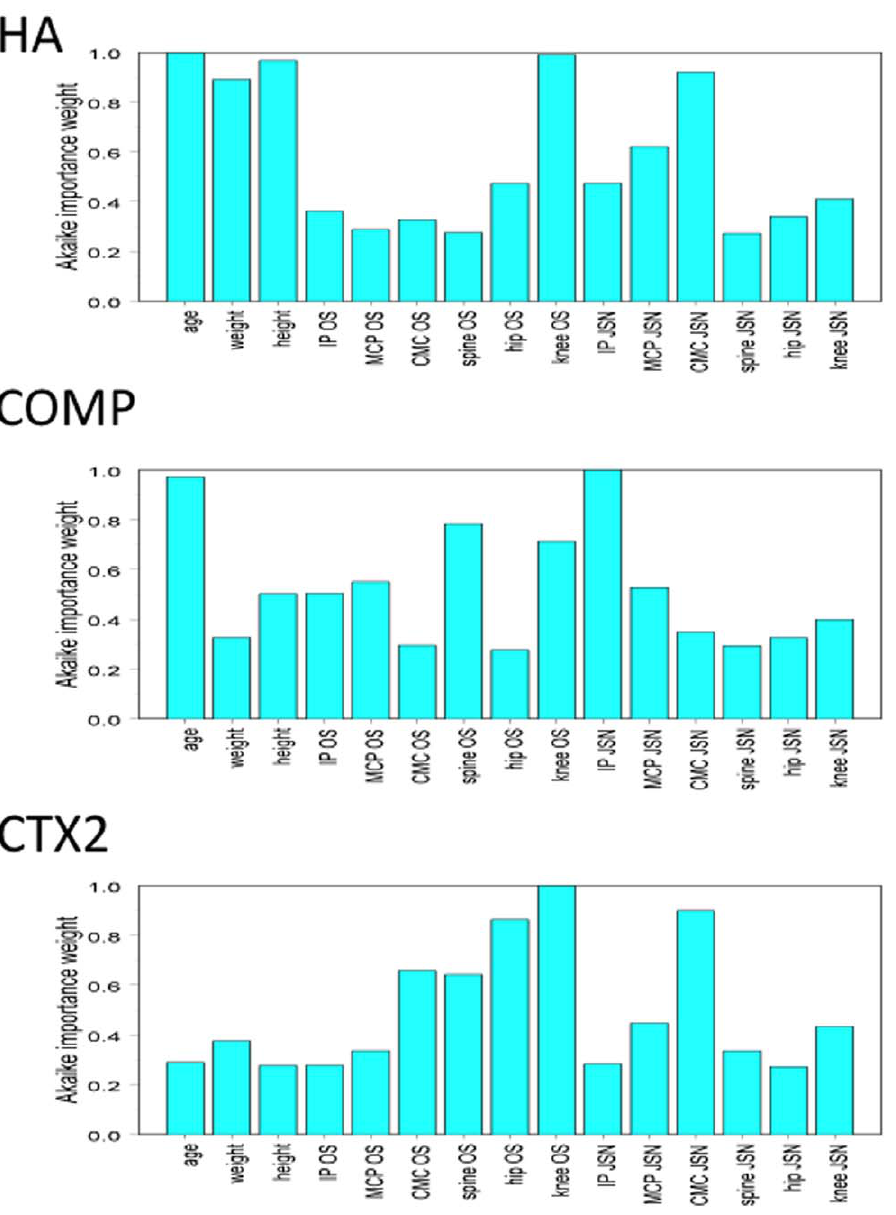
Figure 4. Akaike importance weights for each radiographic feature in linear models for the biomarker concentrations. All first-order linear models were fit, and the Akaike weight computed for each one. The bar height is the Akaike importance weight, the sum of the Akaike weights over all models: the greater the height, the more predictive of biomarker concentration.